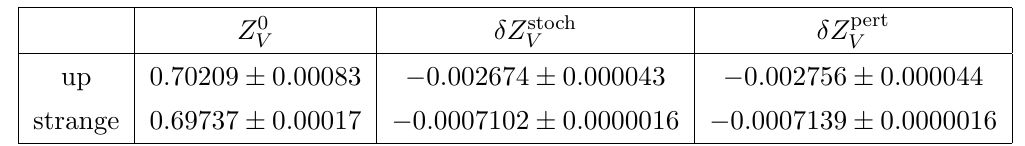
Table 6 . Results for the multiplicative renormalization of the vector current without QED Z 0 the QED correction (cid:14)Z V from the perturbative and the stochastic data.